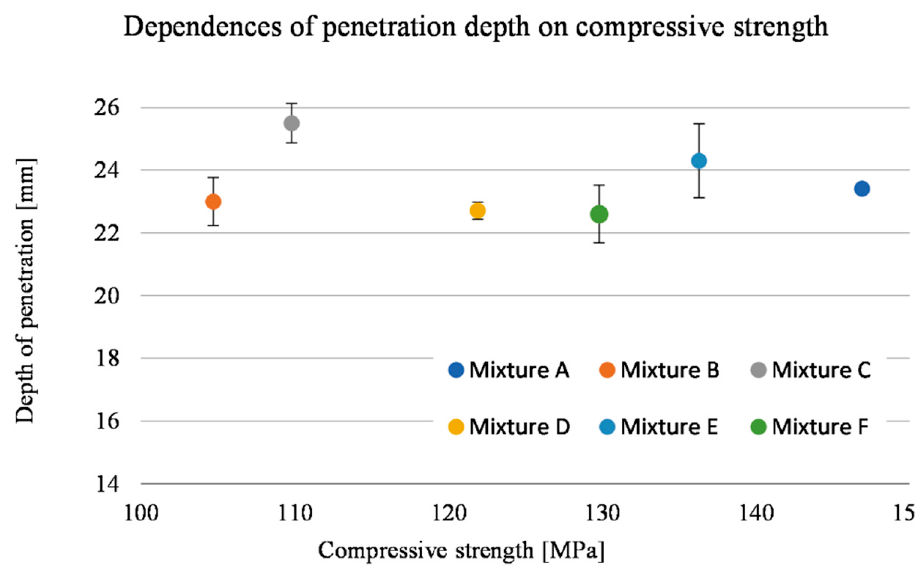
Figure 9. Depth of penetration as a function of compressive strength.